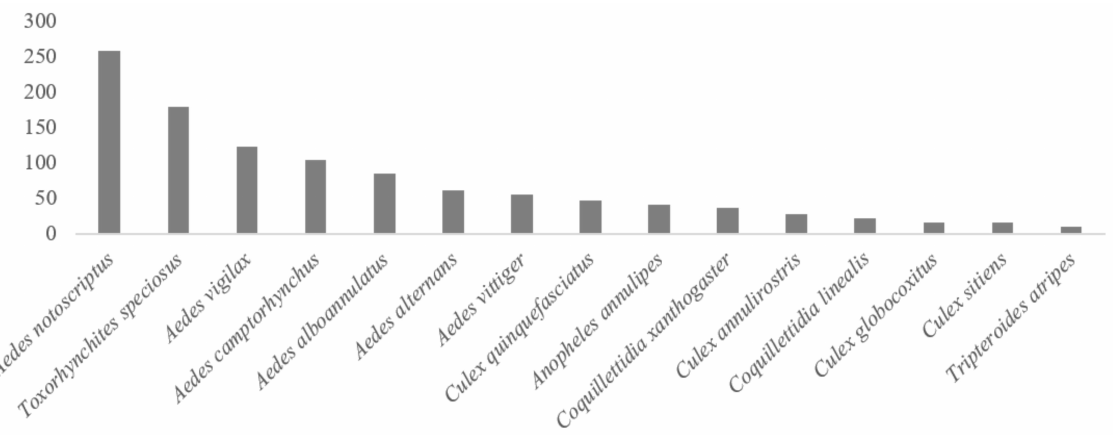
Figure 3. Number of observations of the 15 most observed species of mosquitoes on iNaturalist, in